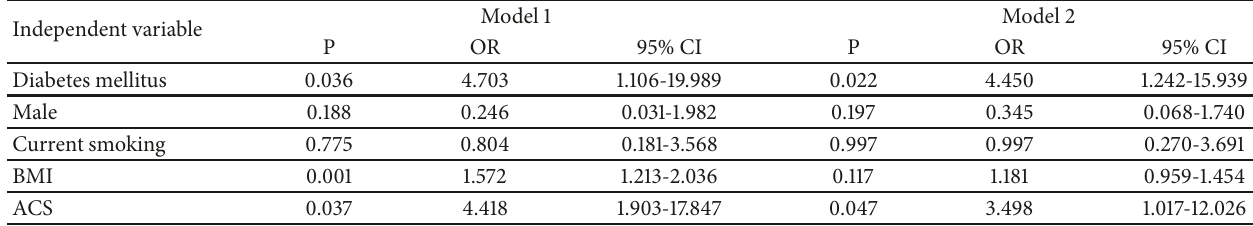
Table 3: Predictors of the presence of plaque vulnerability as detected by ruptured plaque or nonrupture with TCFA: results of multivariate logistic regression analysis.